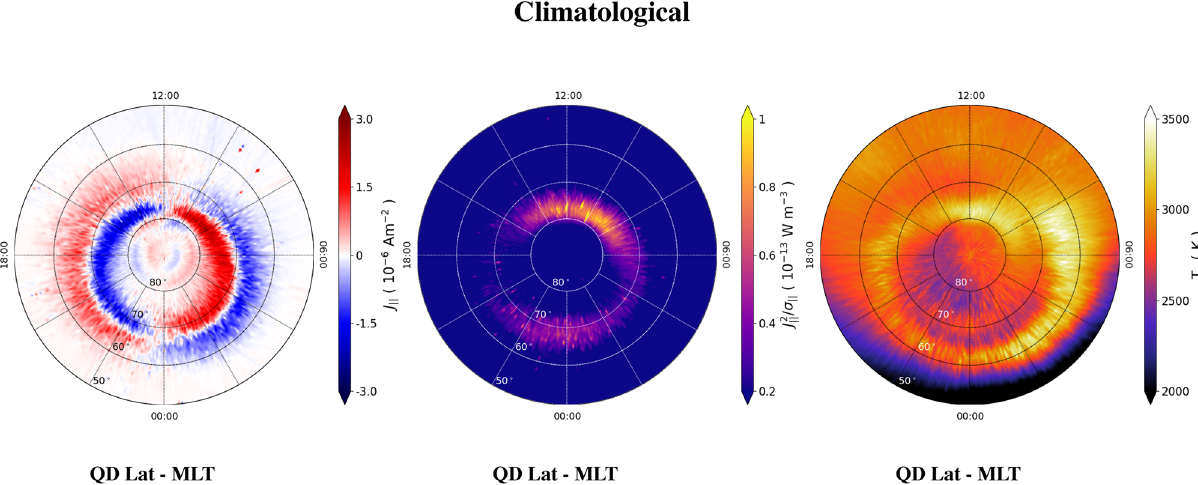
Figure 1. Maps in QD latitude vs MLT coordinates of FAC density, J || , (left panel); dissipated power density, J 2 /σ || , (central panel); and electron temperature, T e , (right panel) in the Northern hemisphere obtained by || considering 6 years of Swarm A data. The values of J || are saturated below -3 × 10 − 6 A m − 2 and above 3 × 10 − 6 A m − 2 ; the values of J 2 || /σ || are saturated below 0.2 × 10 − 13 W m − 3 and above 1.0 × 10 − 13 W m − 3 ; the values of T e are saturated below 2000 K and above 3500